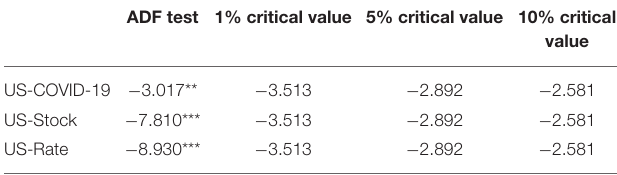
TABLE 4 | The result of unit root test of the United States’s data